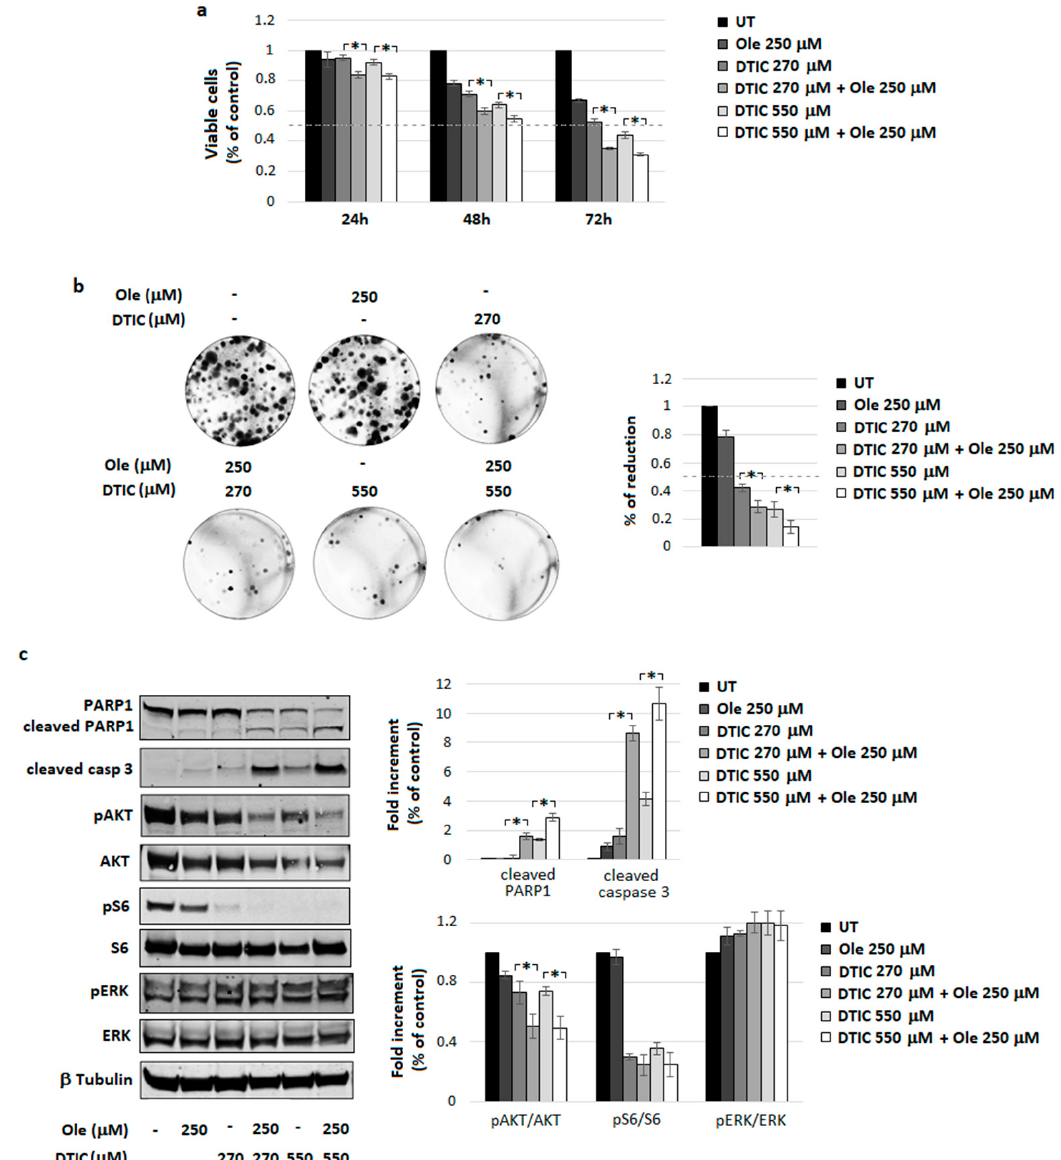
Figure 2. Ole-Dacarbazine (DTIC) efficacy on A375 melanoma cells. ( a ) Dose–time response evaluated via MTT assay. ( b ) ( Left ) Colony Forming Units (CFU) assay of alive cells selected using a trypan blue exclusion test after the treatment with 250 µ M ( ≈ 125 µ g/mL) Ole and/or 270 and 540 µ M DTIC ( ≈ 50 and 100 µ g/mL) for 72 h. ( Right ) Quantification data of colony numbers compared to UT. ( c ) ( Left ) Representative Western blot of PARP1, cleaved PARP1, cleaved caspase 3, pAKT, AKT, pS6, S6, pERK, and ERK after a 250 µ M Ole treatment and/or 270 and 540 µ M DTIC for 48 h. ( Right ) Densitometric quantification of the cleaved PARP1, cleaved caspase 3, and of the ratio of pERK/ERK, pAKT/AKT, and pS6/S6 relative to β -tubulin expression, expressed as a fold increment (%) compared to UT. * p ≤ 0.05 refers to Ole-DTIC treatment vs. DTIC alone. UT =